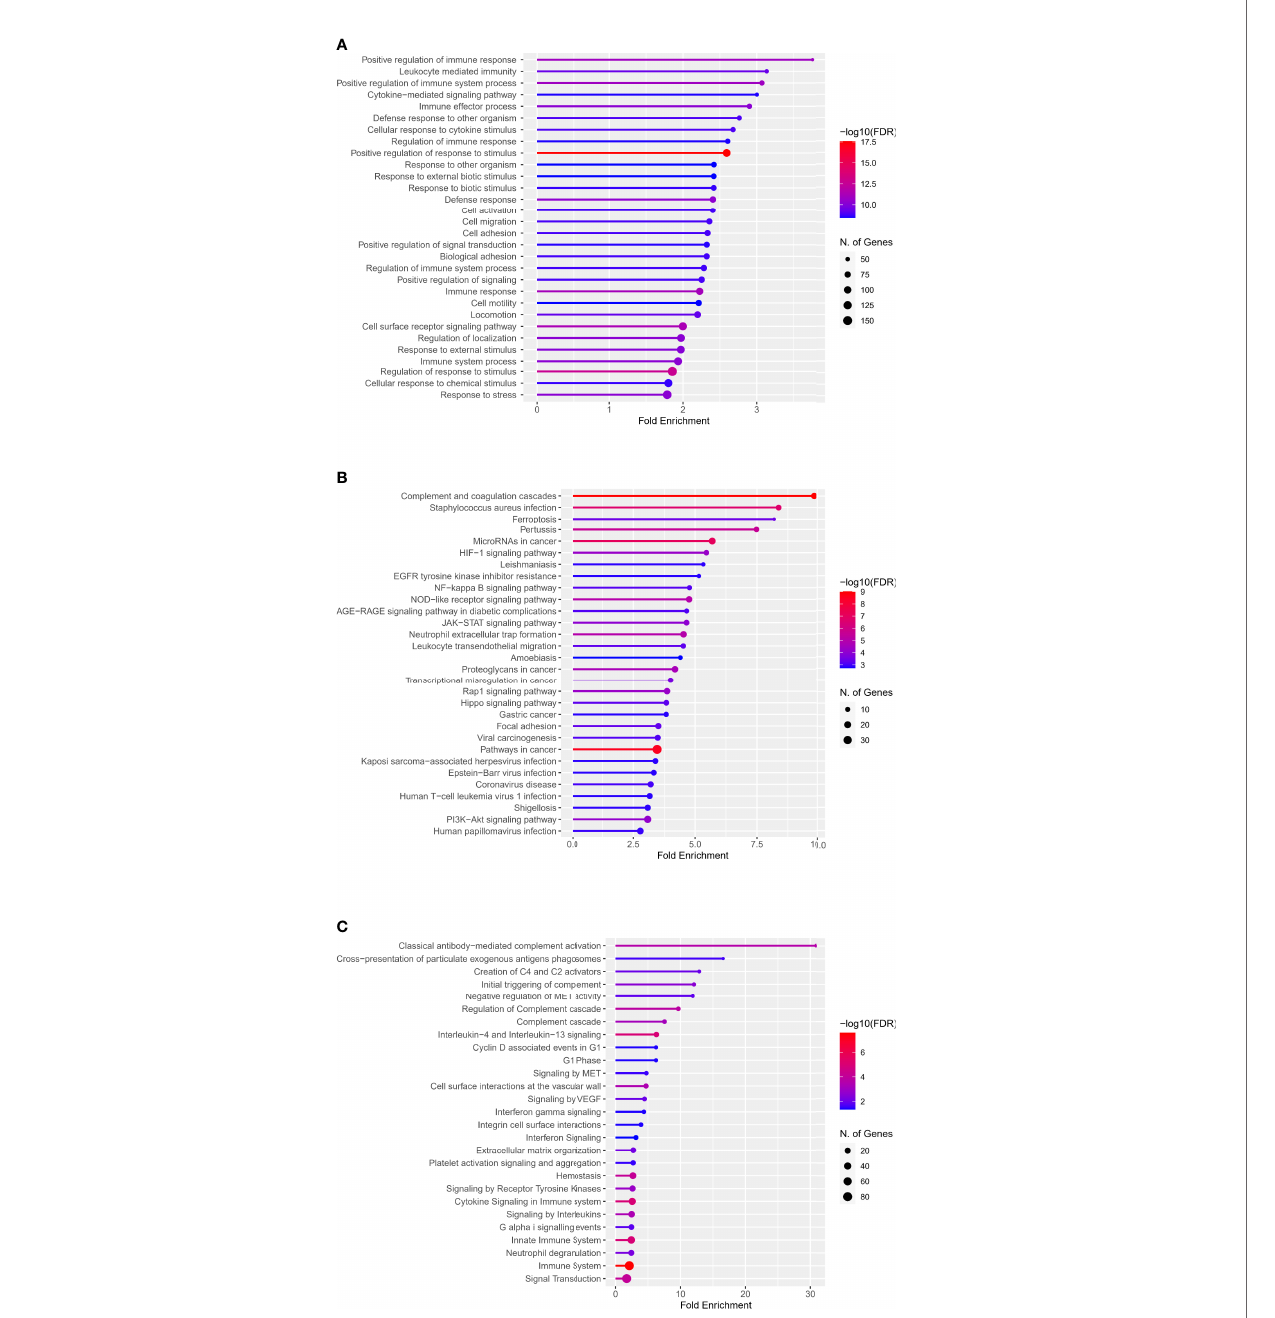
FIGURE 2 | Enrichment analysis of DECD8+TRGs in GO, KEGG and Reactome pathways. (A) Top 30 terms of DECD8+TRGs enrichment in the biological process of GO. (B) Top 30 terms of DECD8+TRGs enriched in KEGG pathway. (C) Top 30 terms of DECD8+TRGs enriched in Reactome pathway. Fold enrichment =